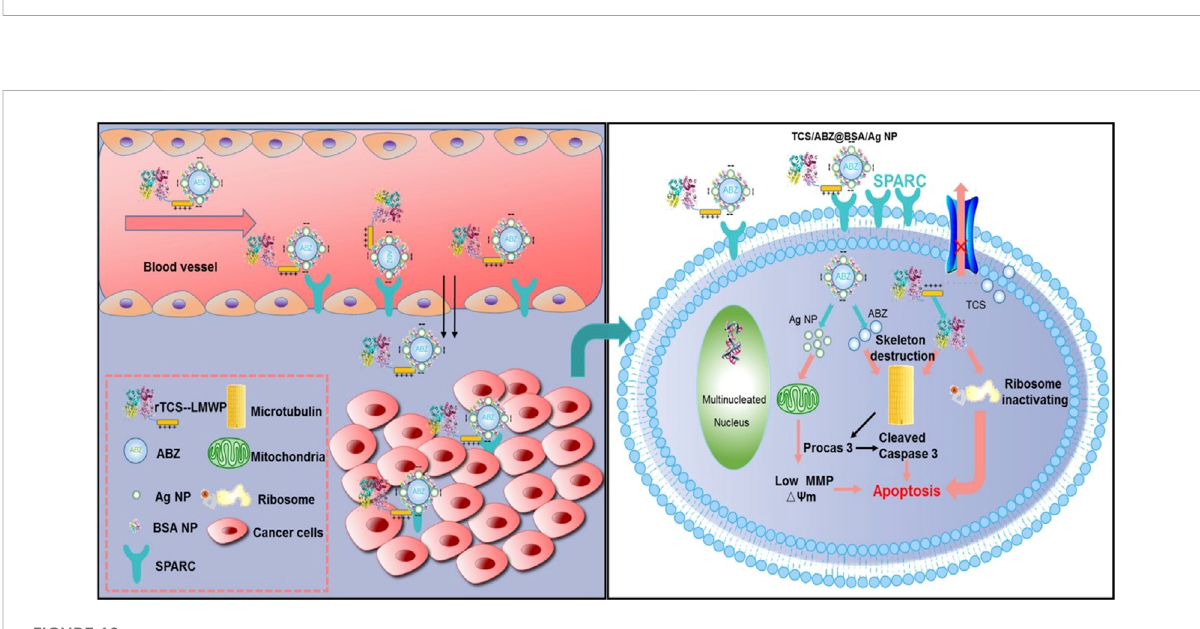
Frontiers in Bioengineering and